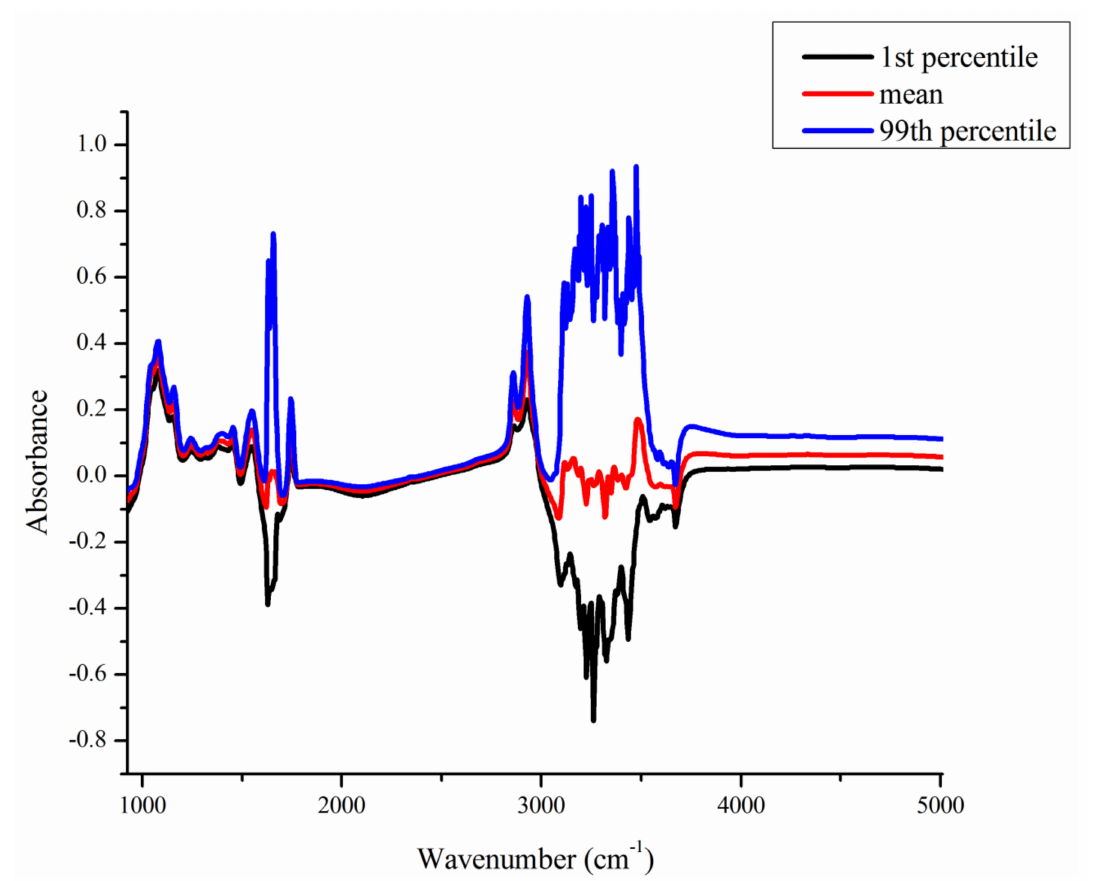
Figure 1. The mean absorbance for 1060 infrared wavenumbers, and the corresponding 1st percentile and 99th percentile, based on records of 371 milk